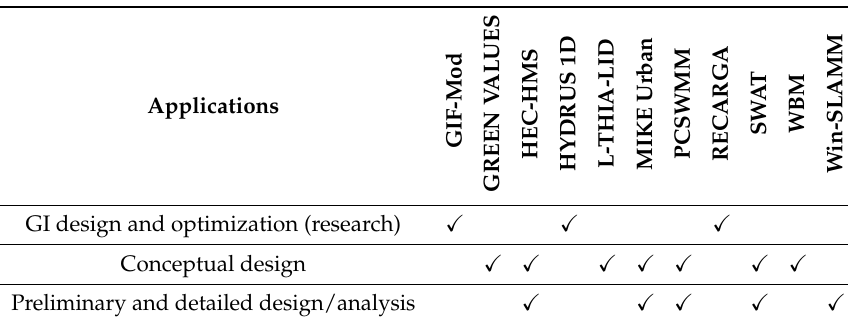
Table 3. Comparing the selected model